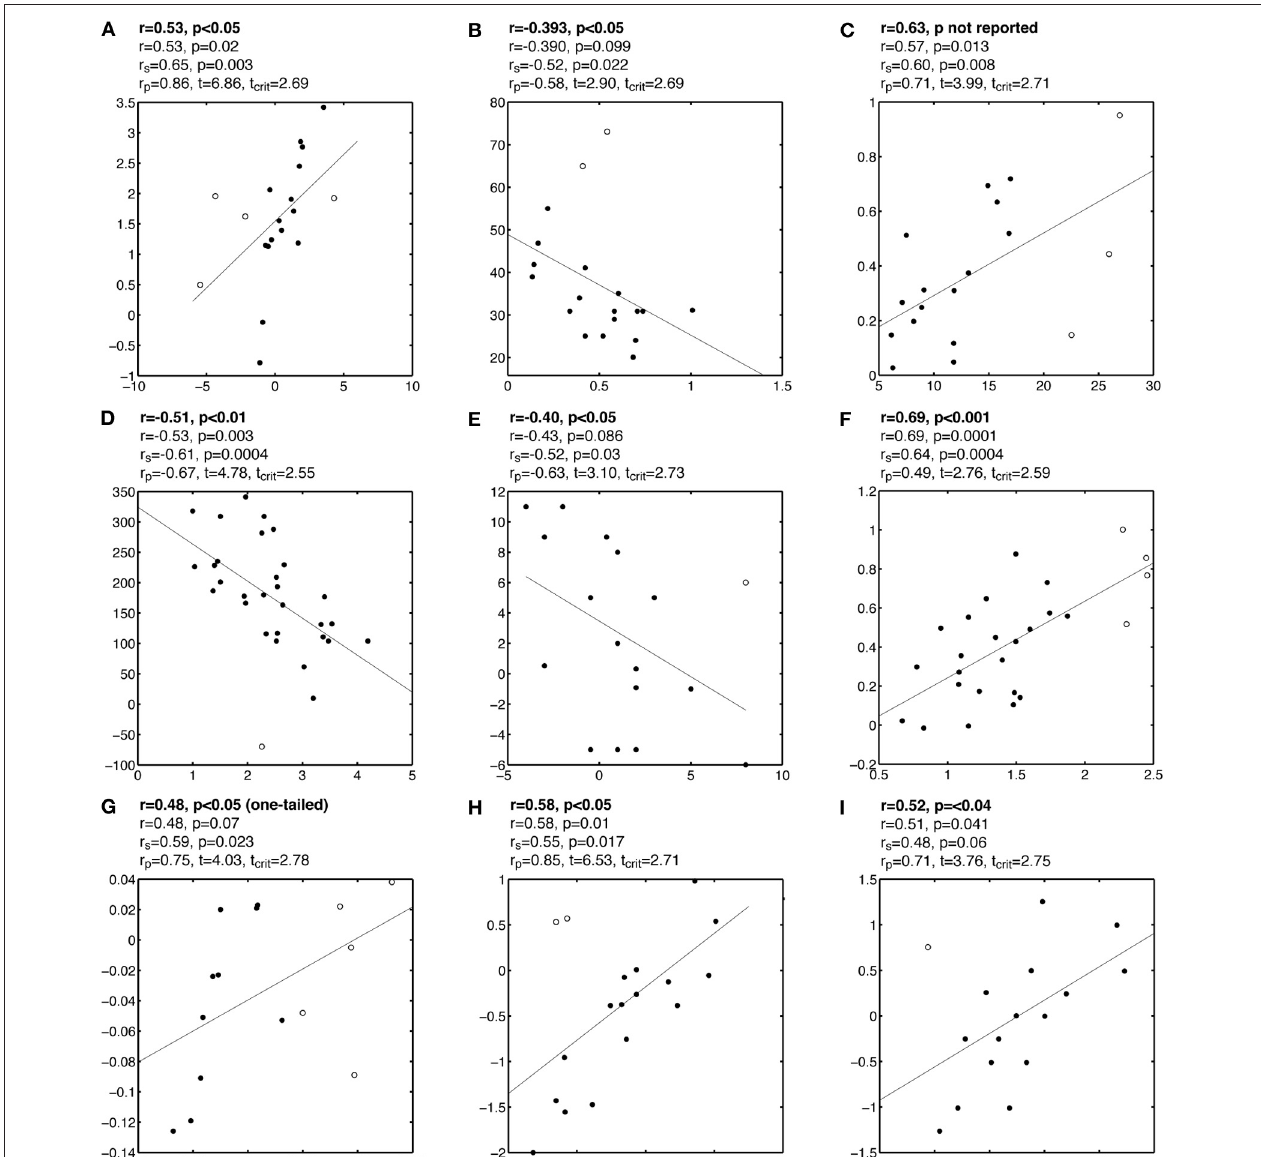
FIGURE A4 | Examples of correlations potentially masked by outliers. See Figure A1 caption for